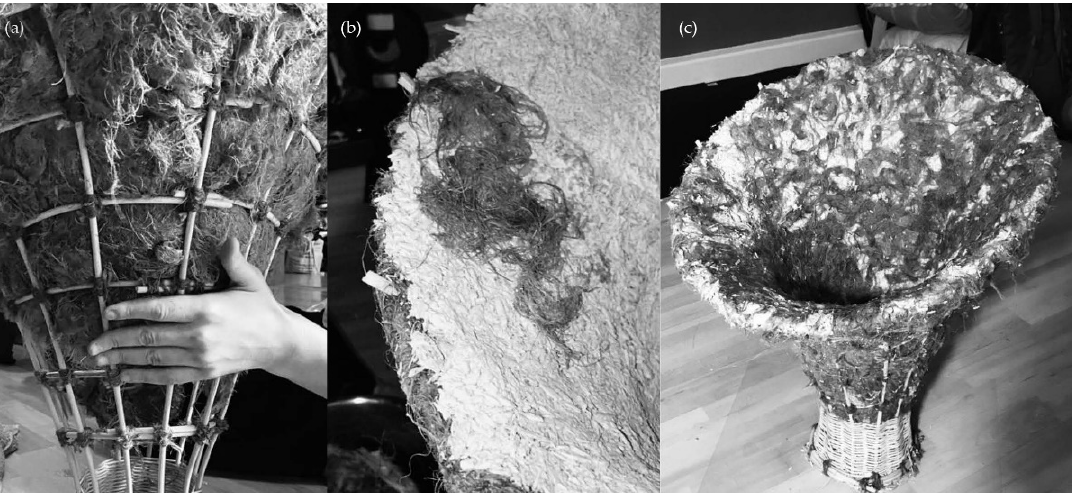
Figure 12. Assembly: ( a ), placing of fibers, ( b ) substrate and cover with additional layer of fibers, ( c ) assembled stool left to grow.